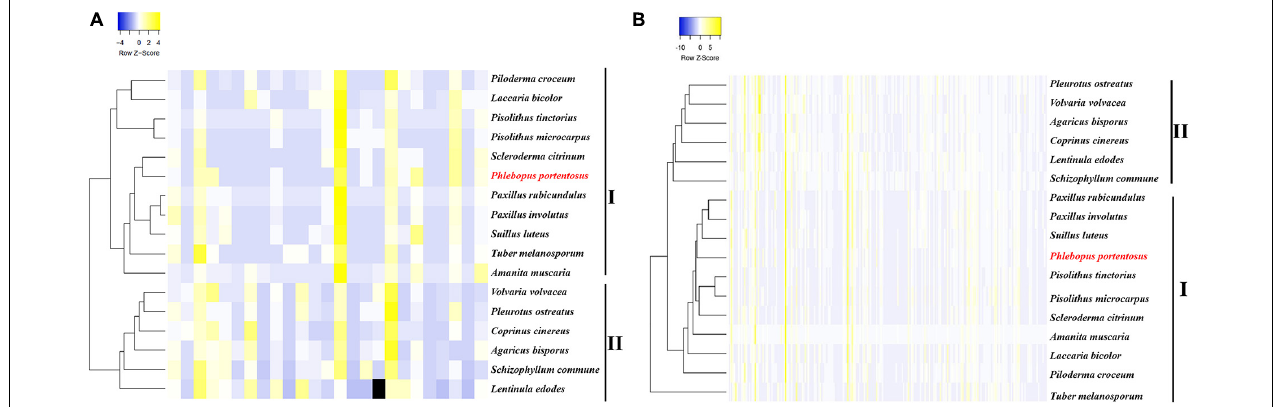
TABLE 3 | The distribution of genes related to lignocellulose degradation in P. portentosus and other fungi. Enzyme EC Saprophytic Ectomycorrhizal SC LE PO CC VV AB PP Lb AM PI PR PC PM PT SCC SL TM Cellulase